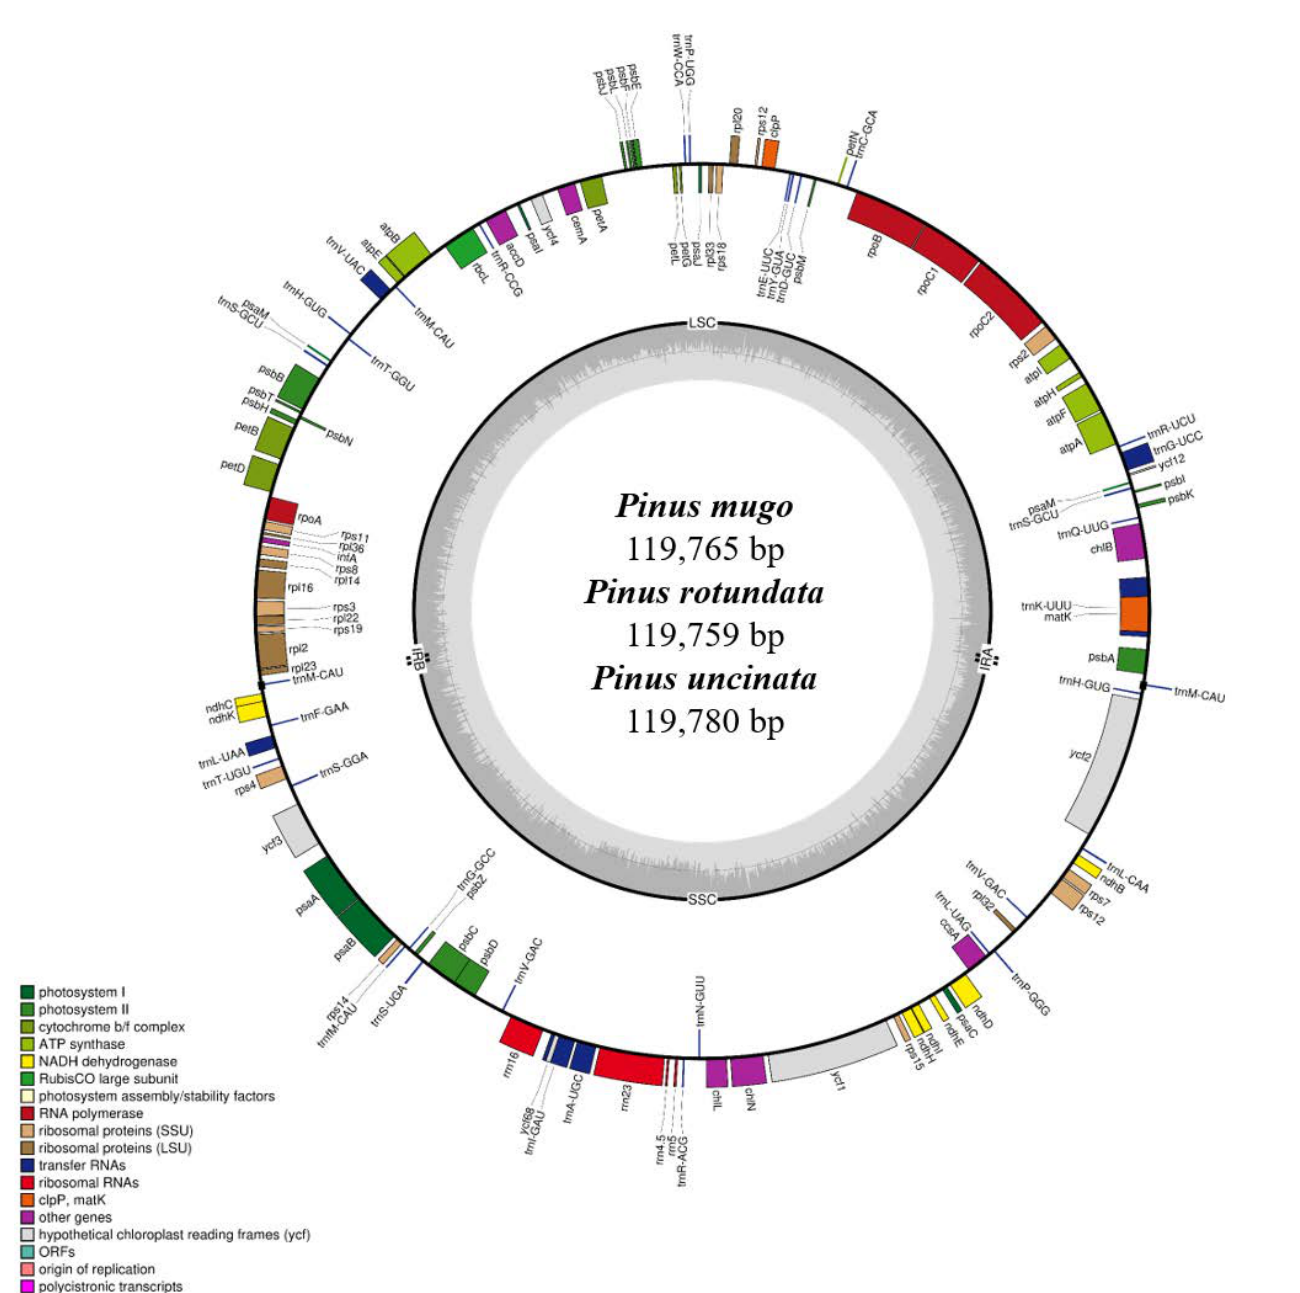
Figure 1. Gene maps of the three Pinus chloroplast genomes. The genes inside the circle are transcribed clockwise, and those outside are transcribed counterclockwise. Genes of different functions are color coded. The darker gray in the inner circle shows the GC content, while the lighter gray shows the AT content. IRA, IRB, inverted repeats; LSC, large single copy region; SSC, small single copy